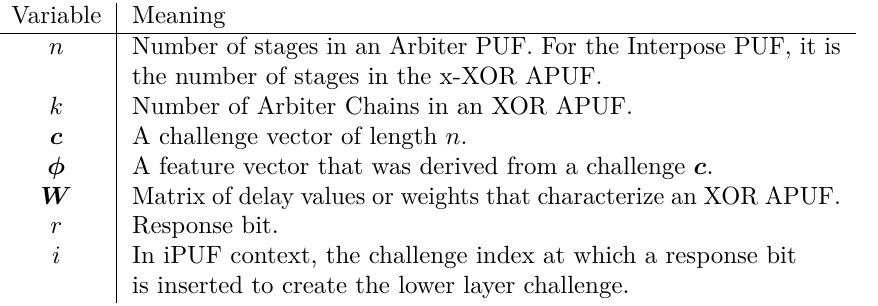
Table 1: Commonly used variable